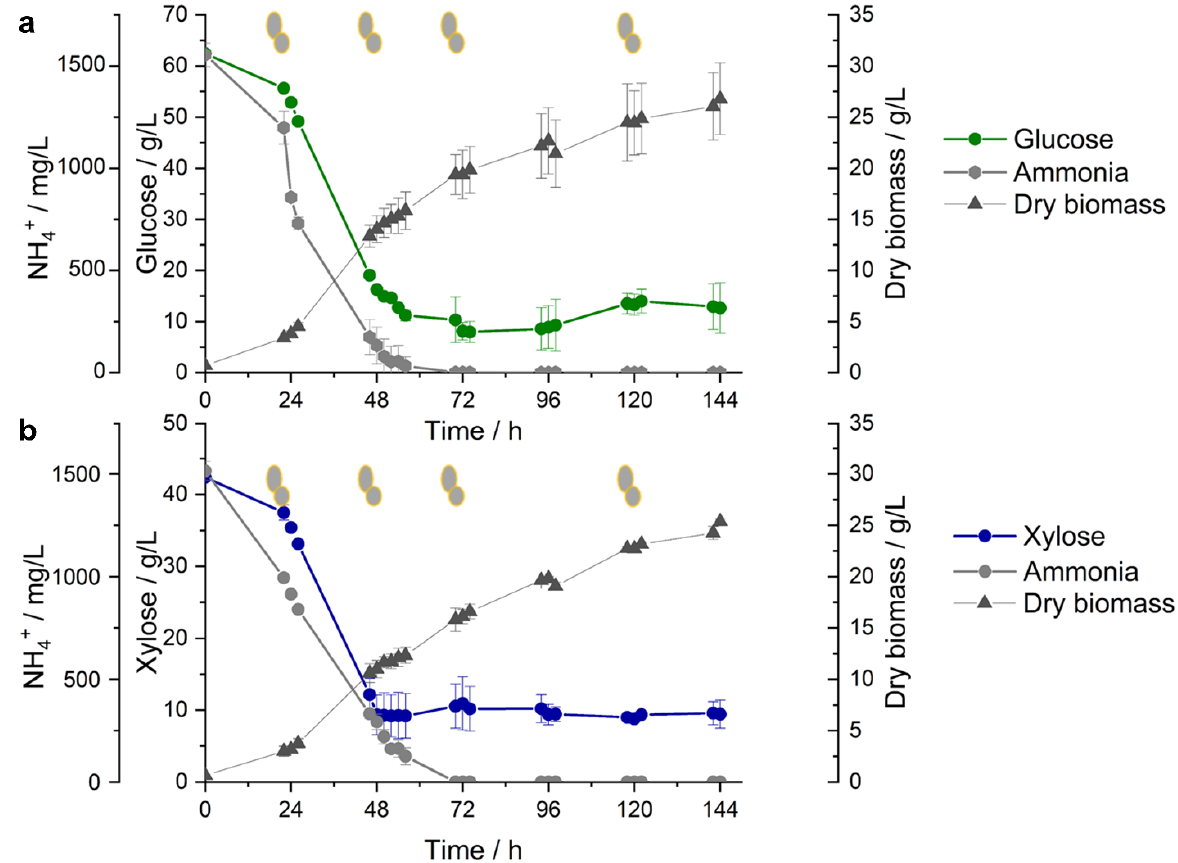
Figure 1. Overview of Saitozyma podzolica DSM 27192 cultivation on ( a ) glucose and ( b ) xylose. A batch-fed process was established at ~48 h for both sugars under nitrogen limitation. Grey cells indicate sampling points at which the yeast was harvested for RNA sequencing and subsequent analyses.